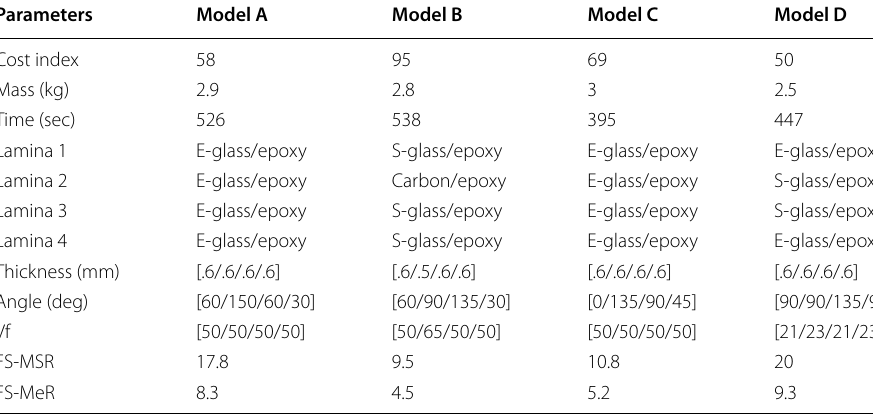
Table 8 Comparison between the four presented optimization models